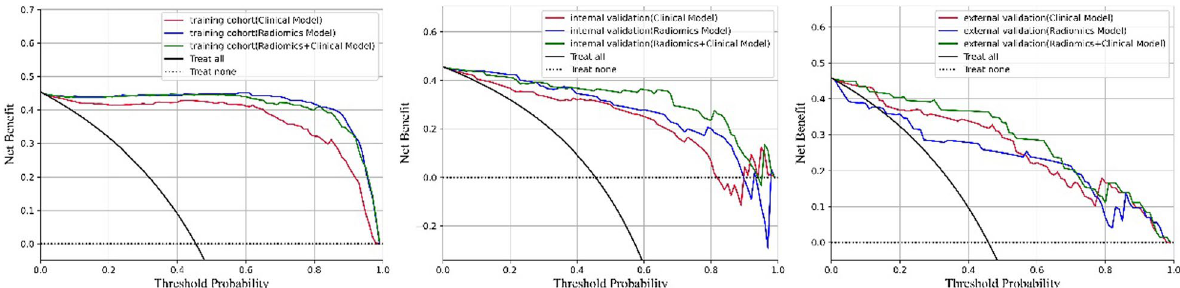
Fig. 7 DCA for the clinical, radiomics, and clinical–radiomics model in the training and validation cohorts (DCA, Decision Curve